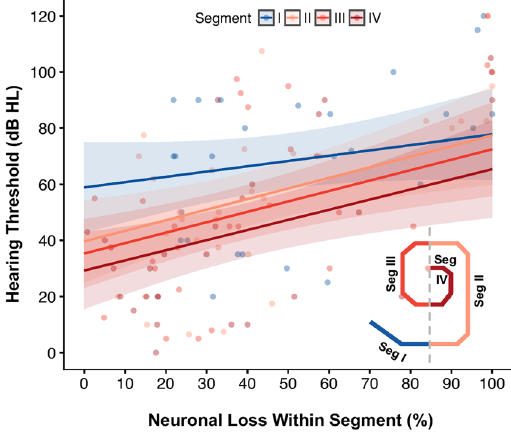
Figure 3. Relationship between hearing thresholds (dB HL) and total neuronal loss (% of age-based mean) does not vary significantly across cochlear length within patients with severe neural degeneration (n = 30 ears). Cochlear length analyzed in four segments (see inset). Solid lines, linear regressions per cochlear segment; shaded areas, 95% confidence intervals for slope; data points, individual observations color-coded by cochlear segment. Conditional f test with Kenward-Rogers correction for degrees of freedom shows that the slopes of these lines are significantly different from zero (p < 0.001), but not significantly different from one another (p =